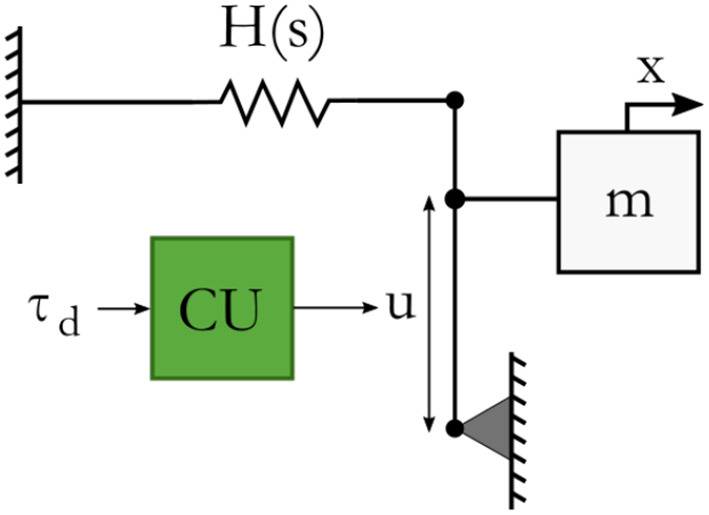
Physical representation of an energy budgeted actuation controller.